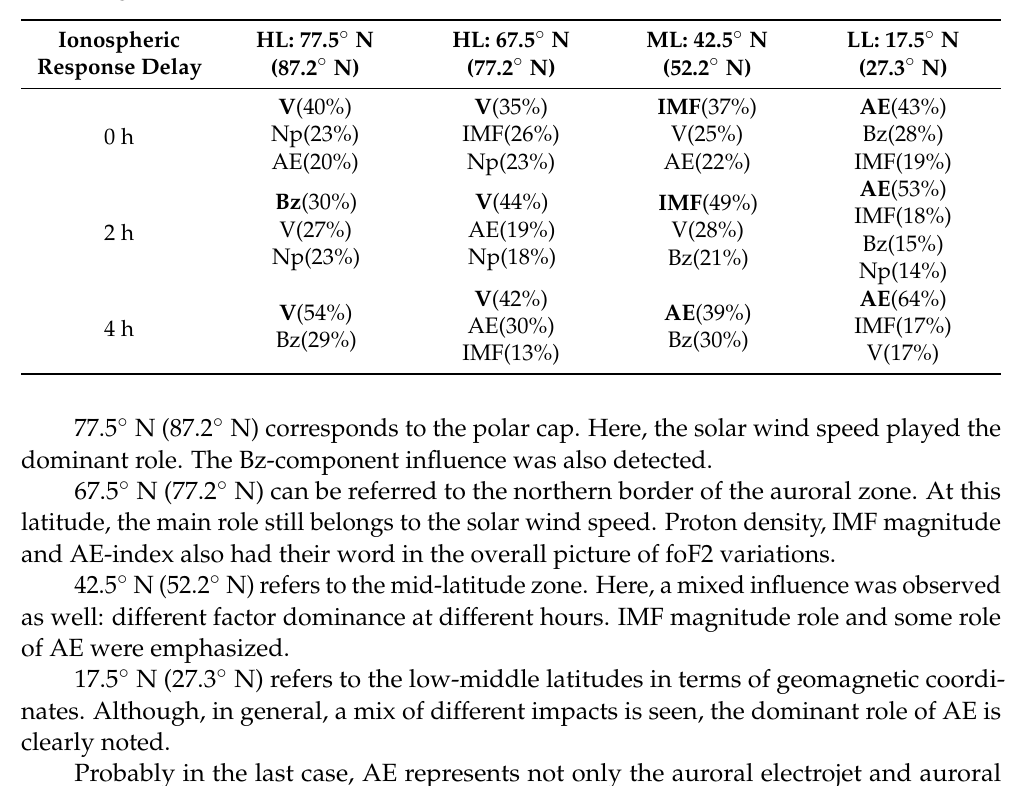
Table 2. Main contributors to foF2(rec) at high latitudes (HL), mid latitudes (ML) and low latitudes (LL), along 70 ◦ W.